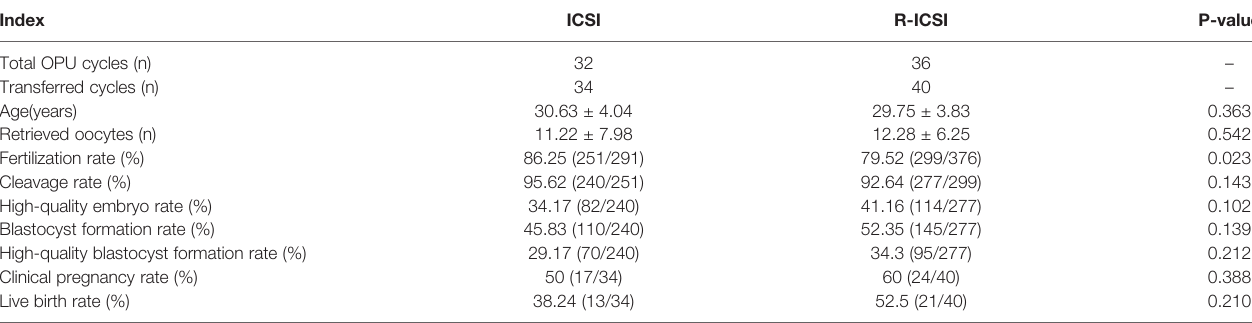
TABLE 3 | Embryological characteristics and clinical results of different insemination methods in the case